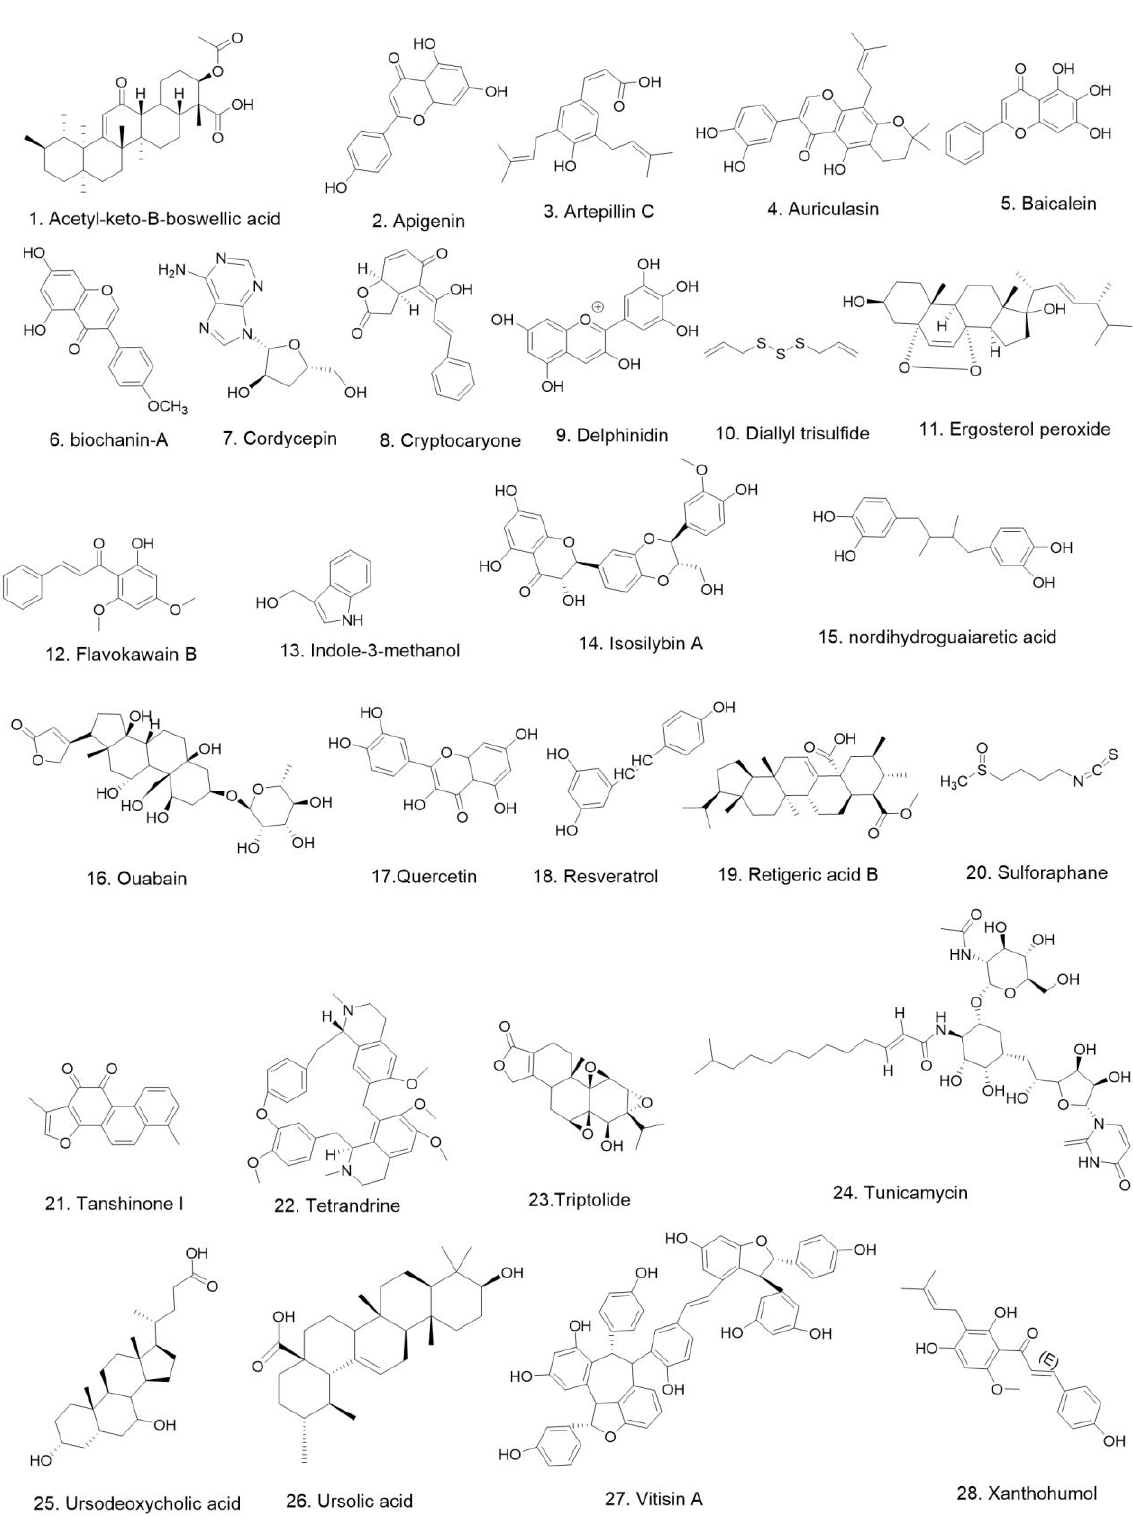
Figure 2. The chemical structures of compounds in Table 2.